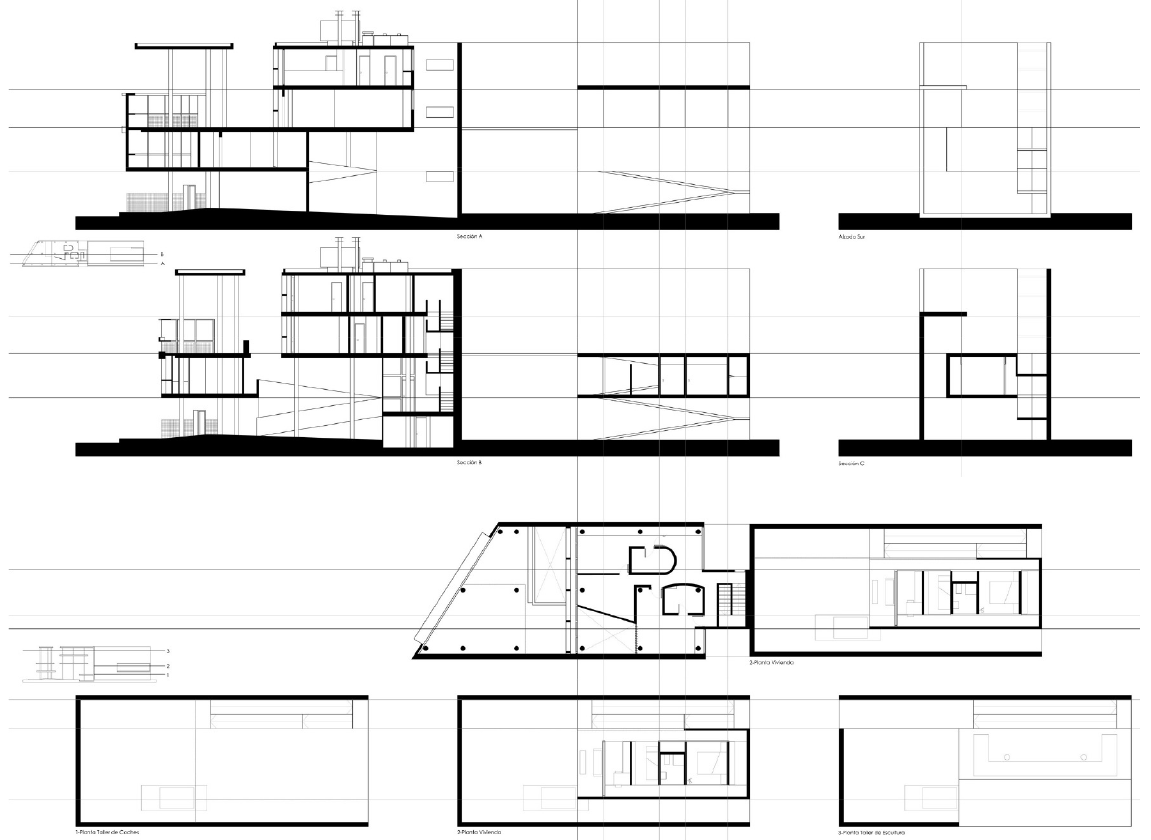
Figure 6. Catching a ray of sunlight. Student: María Sánchez